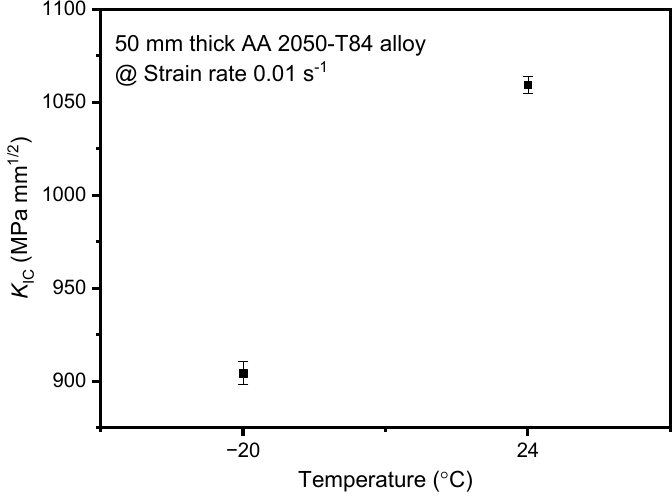
Figure 5. Plane Strain Fracture Toughness ( K IC ) at various